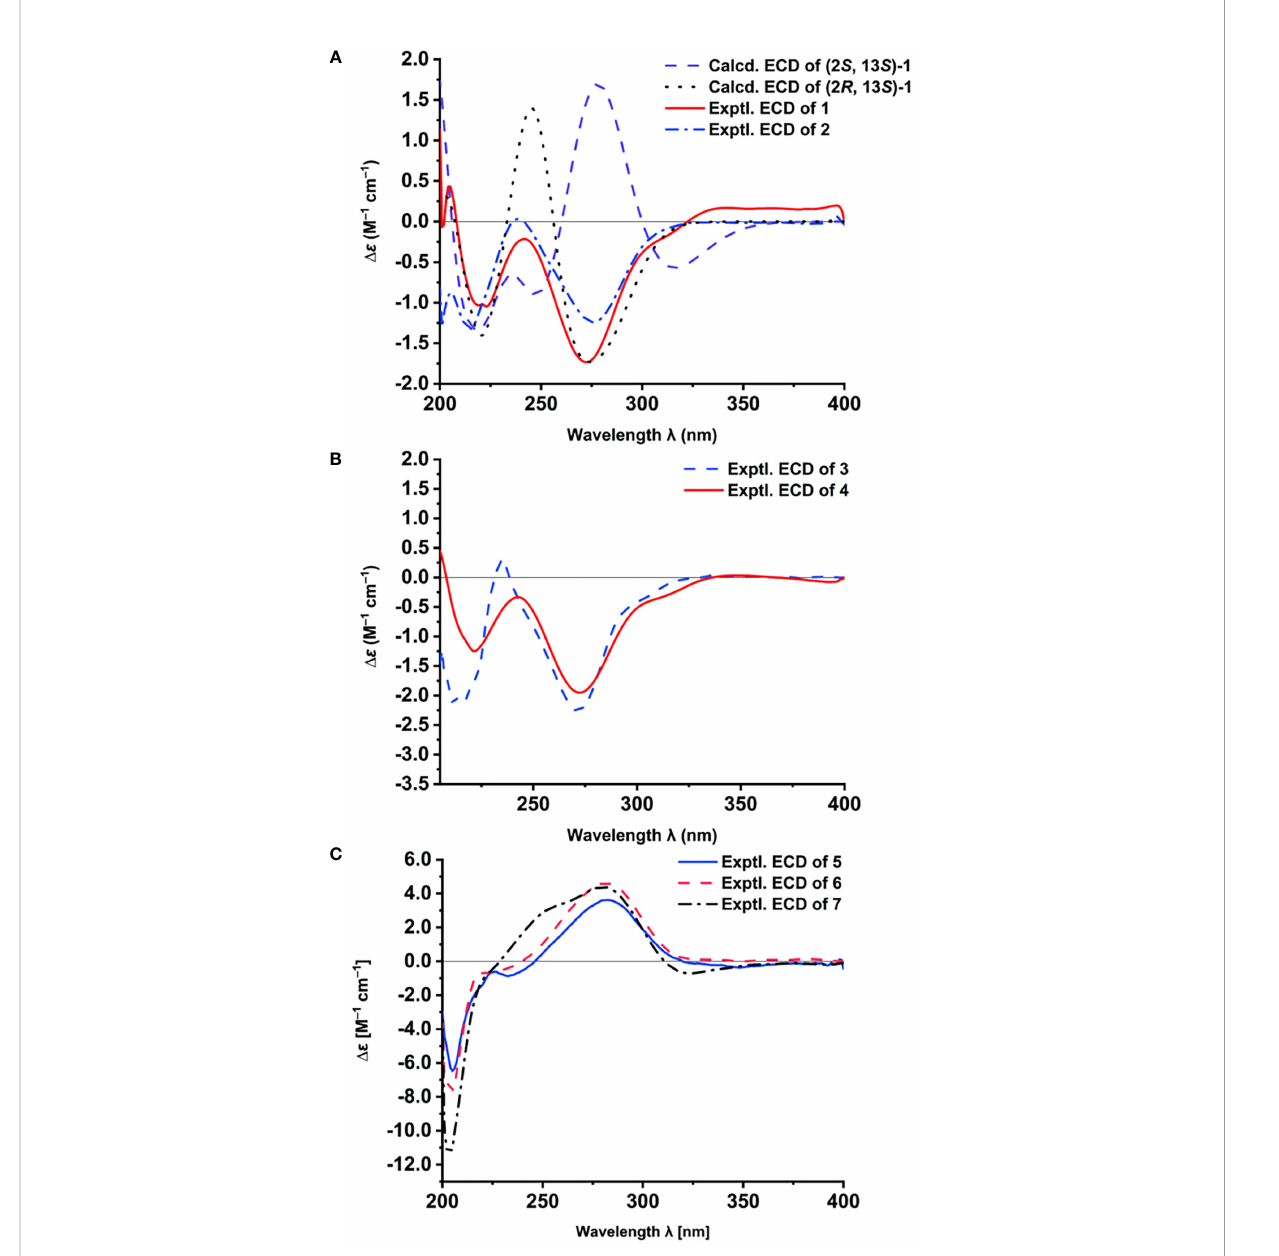
FIGURE 4 The ECD spectra of 1 – 7. Calculated and experimental ECD spectra of 1 and experimental ECD spectrum of 2 (A) ; Experimental ECD spectra of 3 and 4 (B) ; Experimental ECD spectra of 5 – 7 (C)